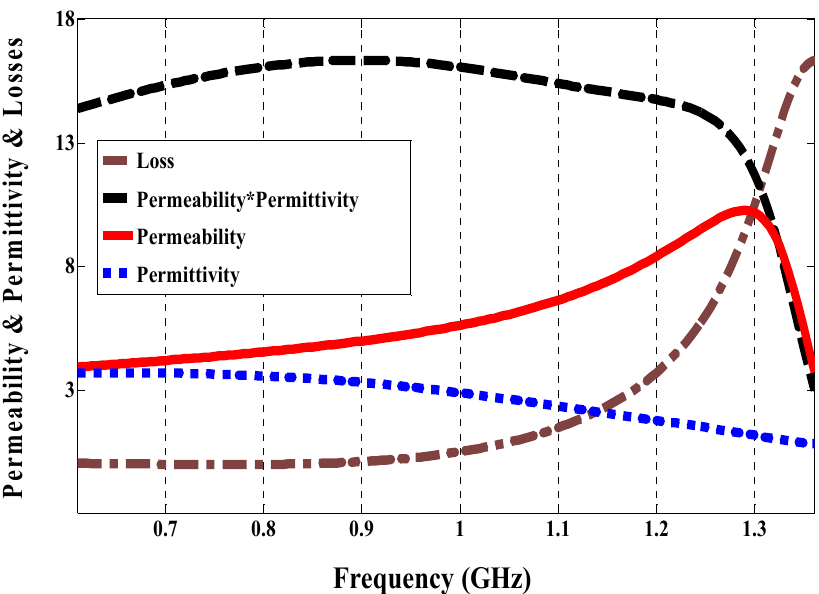
Figure 1. The proposed unit cell under specified boundary condition. The unit cell physical dimensions are Wu = 2.76, Lu = 23.5, Ws = 1.8, Ls = 13.65, d = 0.7, hl = 0.813, hm = 0.203, hu = 0.203. (all dimensions in mm).